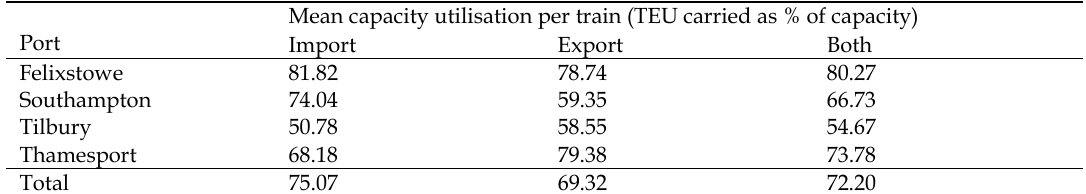
Table 5. Mean TEU capacity utilisation per train, by port and direction of flow Mean capacity utilisation per train (TEU carried as % of capacity) Port Import Export Both